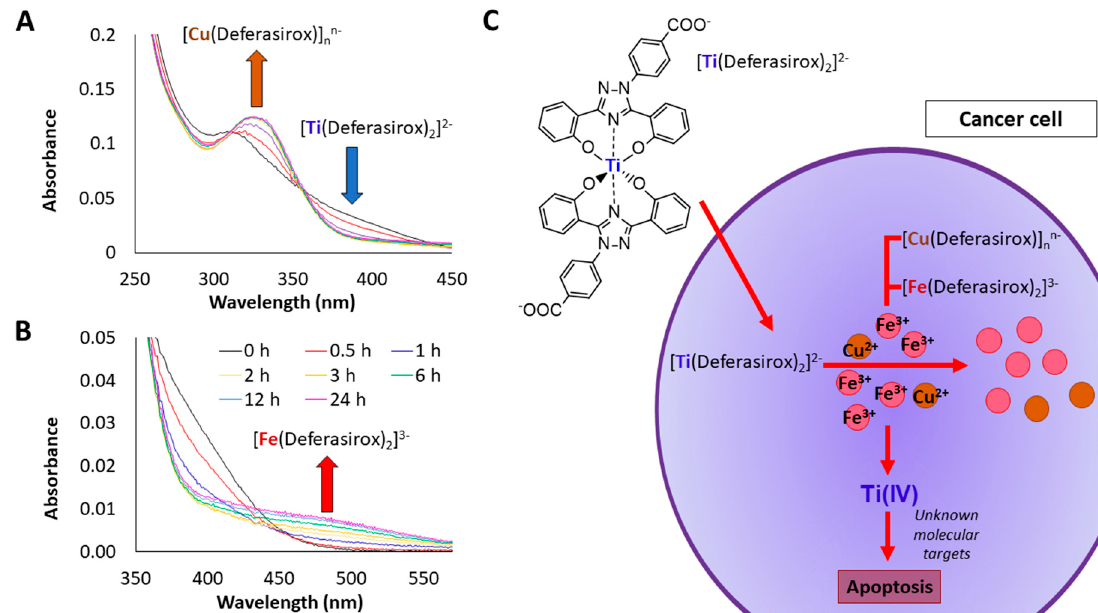
Figure 11. The transmetalation reaction from the simultaneous reaction between Ti(deferasirox) 22 − and labile sources of Fe(III), Cu(II), and Zn(II) monitored by UV-Vis spectroscopy. ( A ) Growth in the ligand to metal charge transfer absorbance for [Cu(Def)] nn − is observed very rapidly. ( B ) Growth in the ligand to metal charge transfer absorbance for [Fe(Def)] 23 − is observed. ( C ) Proposed model for the intracellular transmetalation of Ti(deferasirox) 22 − by Cu(II) and Fe(III) leading to release of Ti(IV) and subsequently apoptosis.